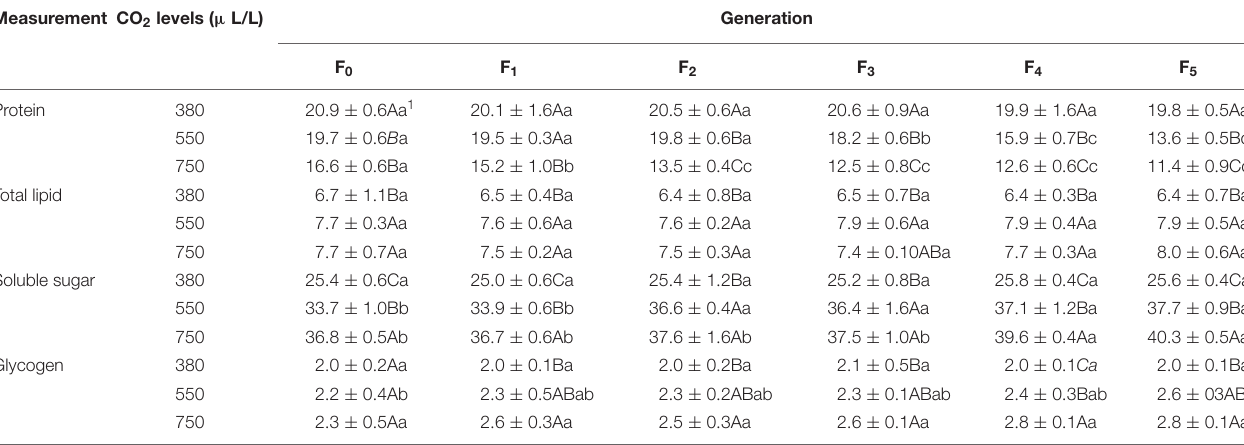
TABLE 2 | Average content (ug/aphid) of protein, soluble sugar, glycogen and total lipid. Measurement CO 2 levels ( µ